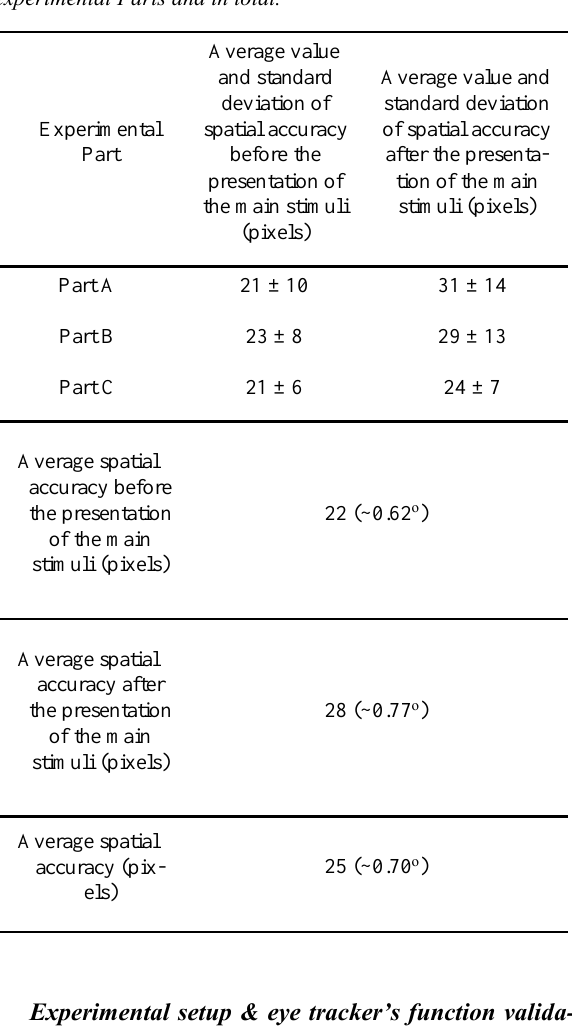
Detection of moving point symbols on cartographic backgrounds